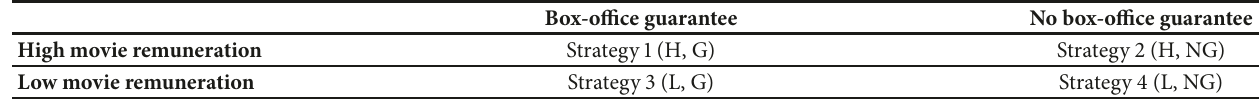
Table 2: Movie star selection strategies.